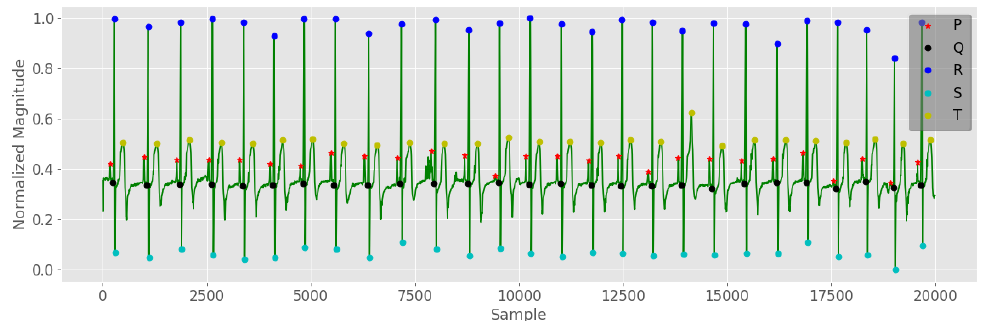
Figure 6. PQRST detection algorithm results.